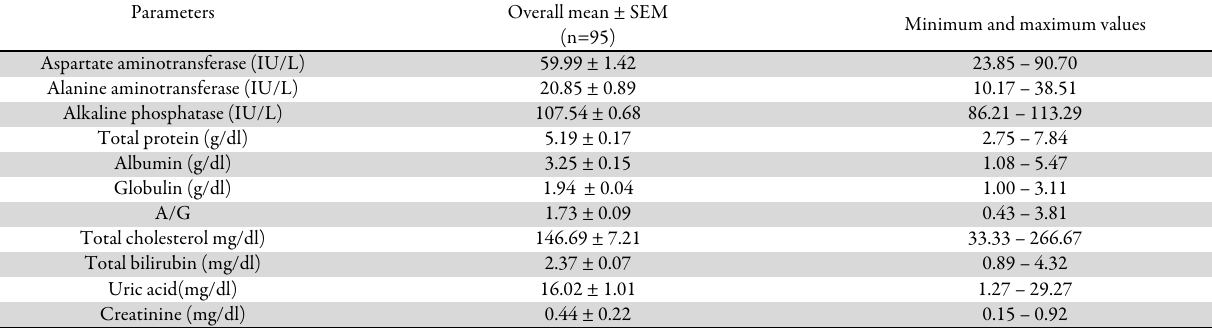
Table 2. The serum biochemistry profile of adult Japanese quail ( Coturnix coturnix japonica ) Parameters